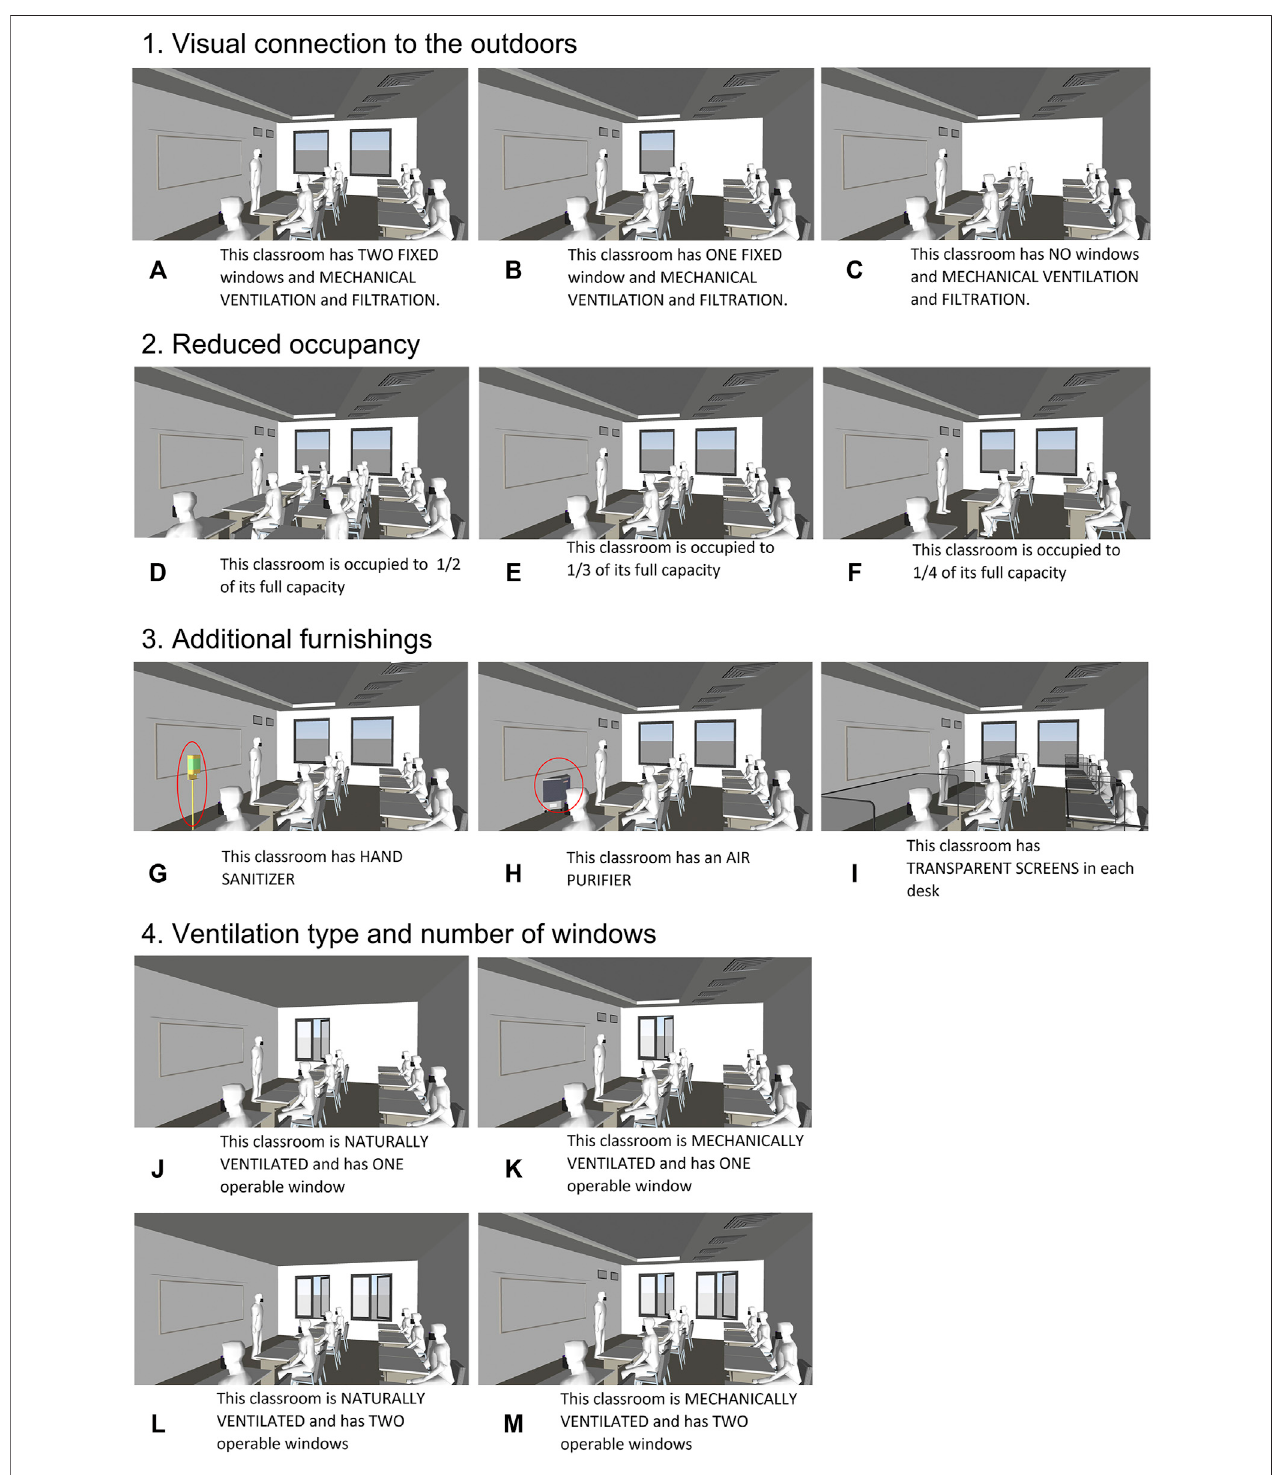
FIGURE 1 | Renderings presented to the participants in the survey to assess risk perception and health promotion in classrooms. Scenarios (A – C) portray variations of visual connections to the outdoors. Scenarios (D – F) portray variations of reduced occupancy. Scenarios (G – I) portray variations of additional furnishings. Scenarios (J – M) portray variations of ventilation type and number of windows.